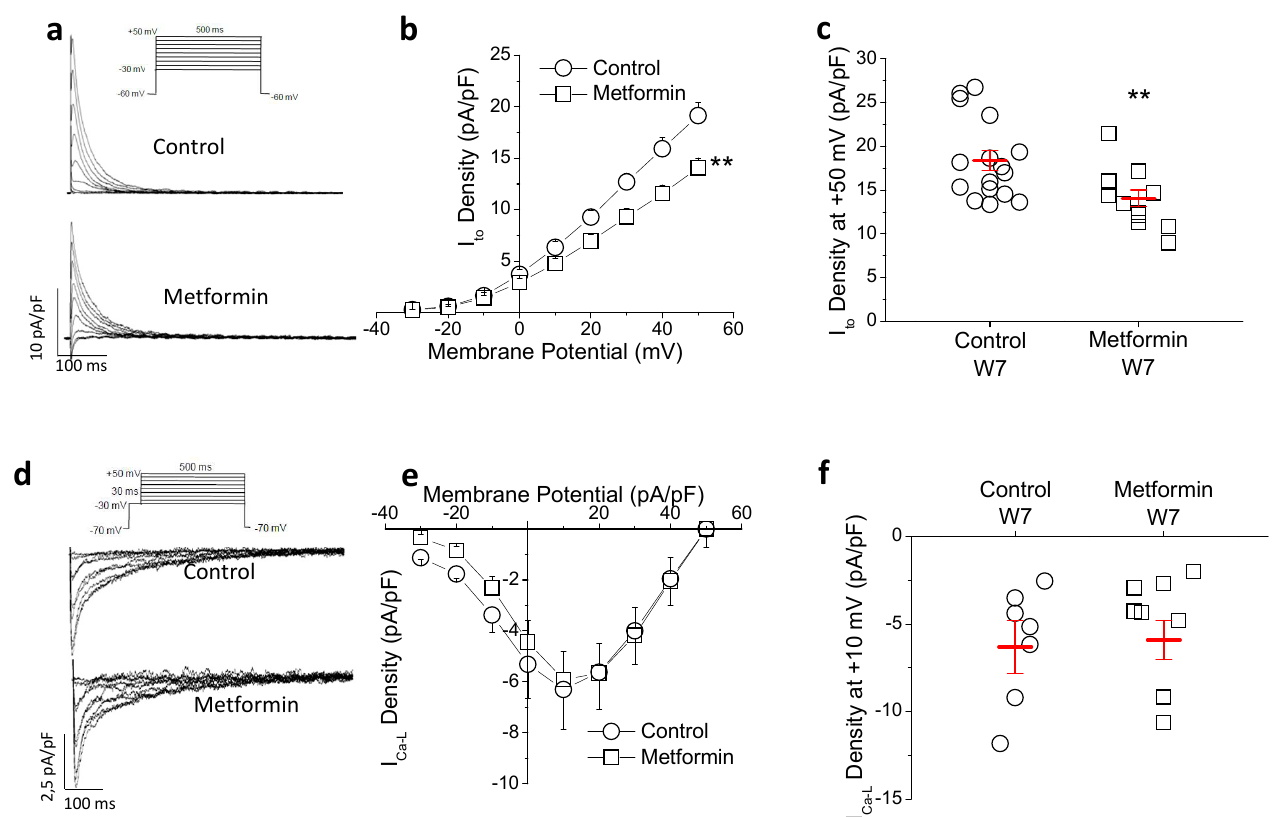
Figure 3. Chronic metformin treatment (35 mg/kg × day) reduces I to and does not affect I Ca-L . ( a ) Representative traces of I to recorded from cardiomyocytes isolated from a control and a metformin- treated rat. ( b ) Average current density–voltage relationships of I to and ( c ) peak values at +50 mV. (n = 17 control and 12 metformin) ( d ) I Ca-L traces recorded from cardiomyocytes isolated from a control and a metformin-treated rat, ( e ) current density–voltage relation and ( f ) peak current density values at +10 mV (n = 7 control and 8 metformin). Diagrams of I to and I Ca-L recording